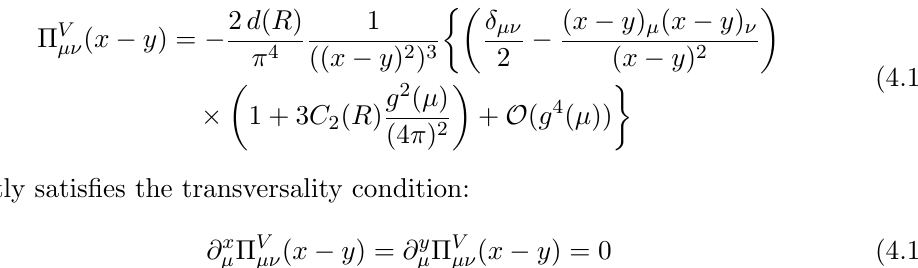
( x (cid:0) y ) at O ( g 0 ) (left) and O ( g 2 ) (centre, right). (cid:22)(cid:23)